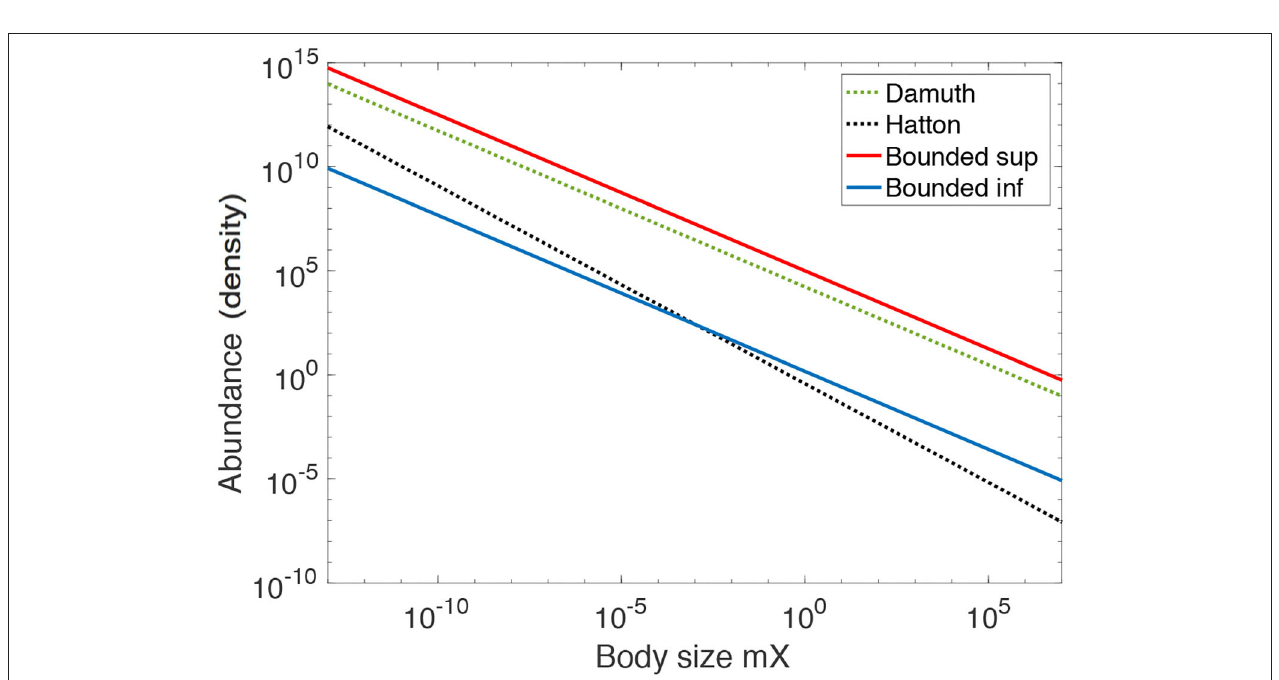
= 5, f = 7, f 0 = 0.5 and, f ∞ = 0.25. CR PC